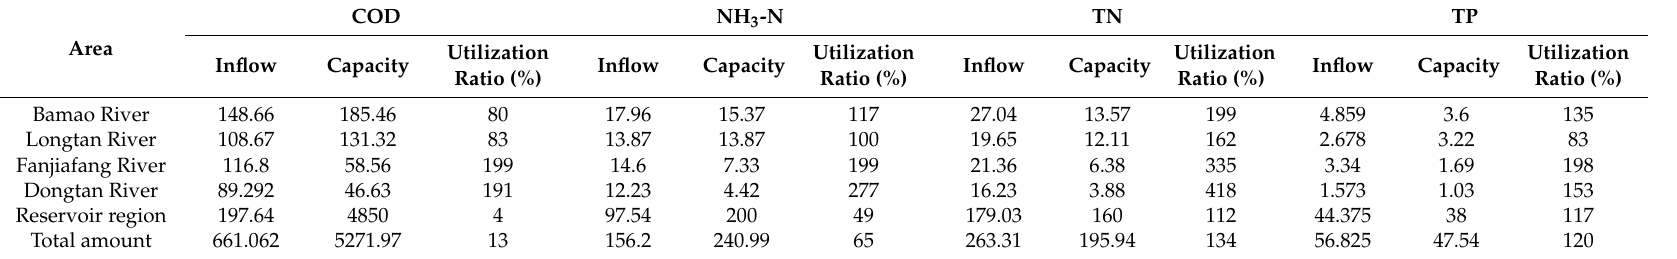
Table 11. The water environmental capacity utilizations of the Huangshi Reservoir in 2014 (units: